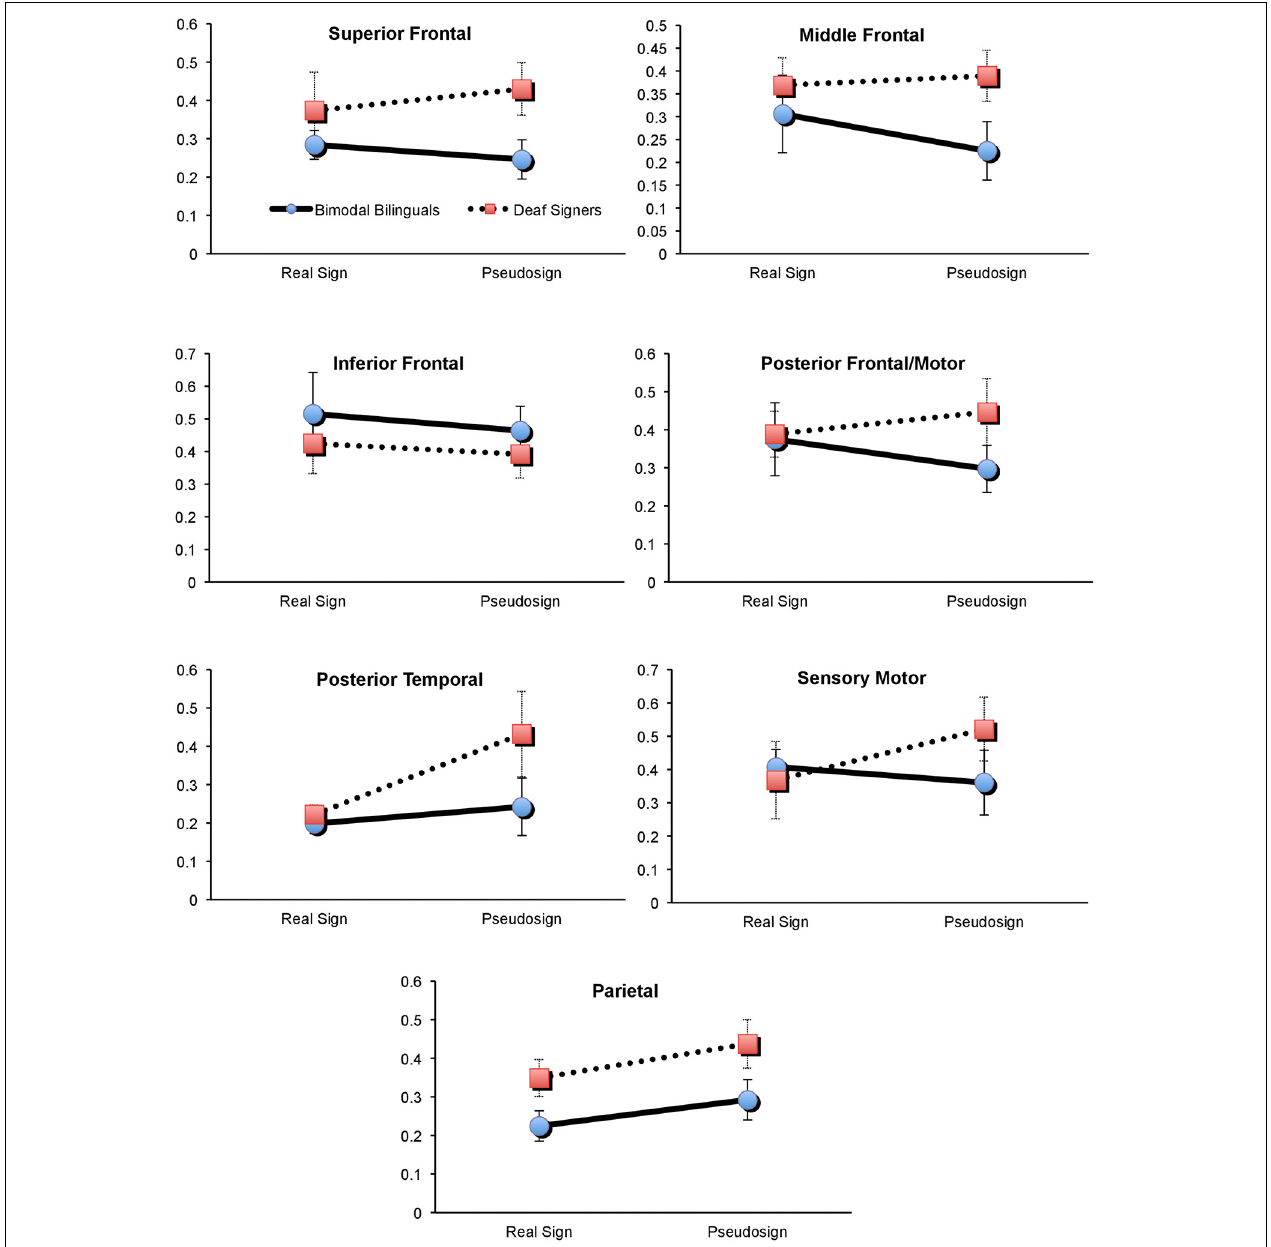
FIGURE 3 | Brain activation in Deaf and Bimodal ASL users during Sign and Pseudosign conditions for all left hemisphere brain regions. Error bars represent standard error of the